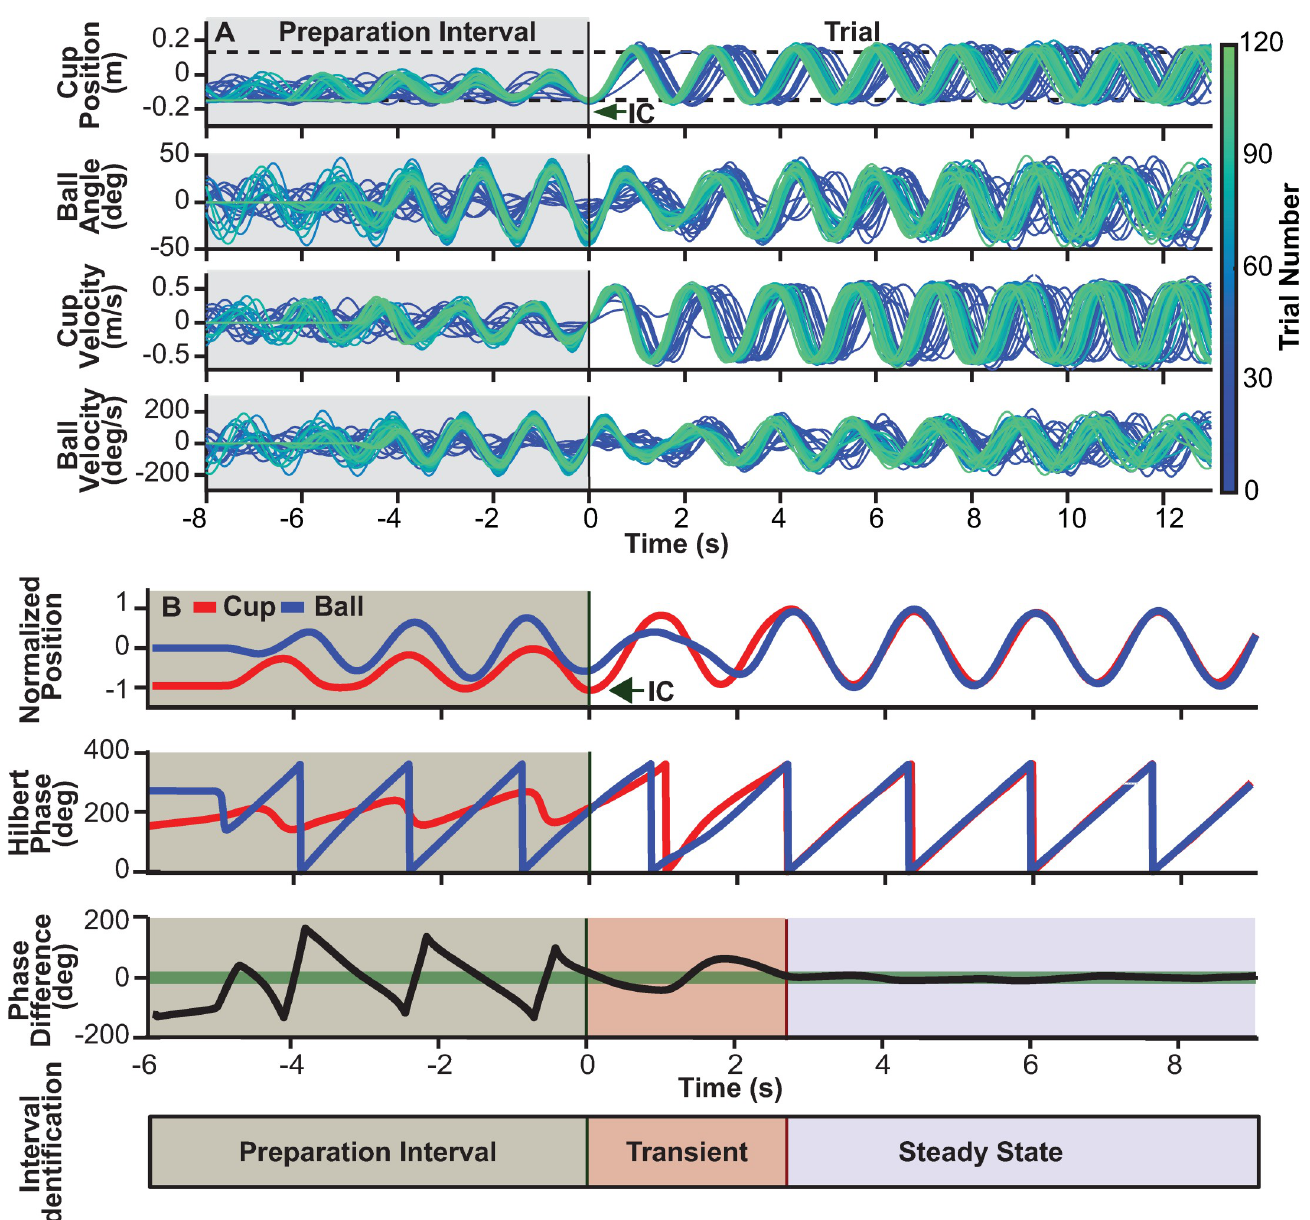
Fig 2. Object kinematics and transient calculation. A. Kinematics of the cup and ball of one sample subject: cup position, ball angle, cup velocity, and ball velocity. The panels show 60 trials (every other trial, with the sequence indicated by the color gradient). The dashed black lines in the top panel with cup position show the instructed cup amplitude, defined by the centers of Box A (-0.15m) and Box B (0.15m). The time series were aligned at the moment of trial initiation when the cup velocity was at its last zero prior to reaching Box B for the first time and starting the regular rhythmic movement. Initial conditions (IC) of all four variables were determined at this time point. B. Top panel shows cup position normalized to ± 1 and ball angle similarly normalized between ± 1. Calculation of relative phase between cup and ball trajectories to parse each trial into a transient and a steady state portion. To demarcate the end of the transient and start of the steady state, the instantaneous phase differences between cup and ball position were computed for the entire trial using the Hilbert Transform. The time point when the phase difference entered and remained within a threshold shown by the thick green line (27 deg or ± 15% of the maximum phase difference of 180 deg) defined the end of the transient and start of the steady